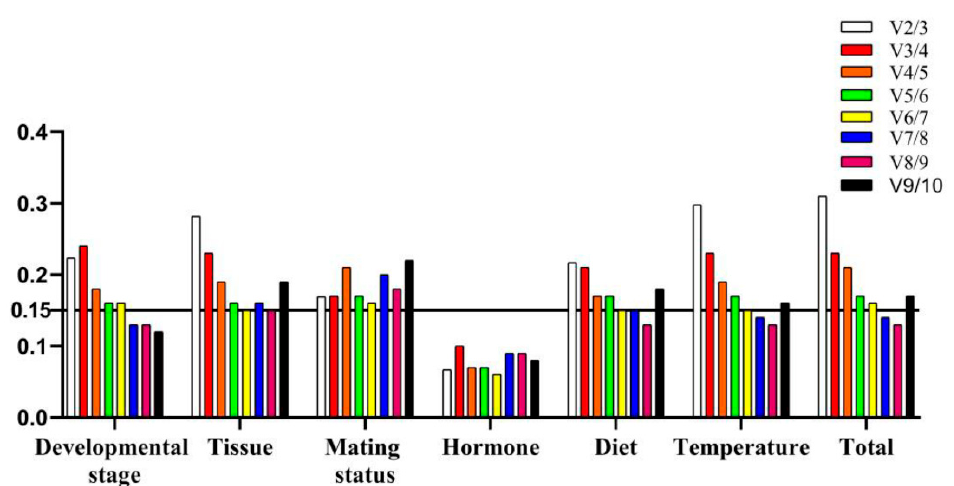
Figure 3. Evaluation of the optimal number of reference genes for normalization of S. frugiperda in different treatments. The dashed line indicates that the pairwise variation is 0.15. Table 3. Expression stability of 10 candidate reference genes of S. frugiperda under hormone treatment, diet treatment, and temperature